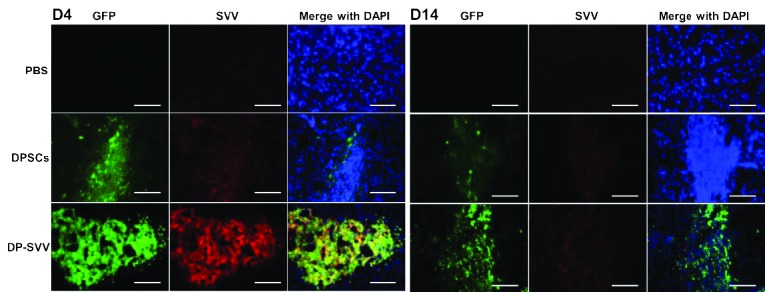
Survival of the control and DP-SVV cells in the wild-type C57B/6 mice 4 and 14 days after transplantation. Microscopic analysis of the immunofluorescence-labeled striatal sections in the cell-transplanted mice. Transplanted cells expressing GFP (green) were immunostained against SVV (red) and counterstained with DAPI (blue). Scale bar, 100 μm. DPSCs, dental pulp-derived stem cells; SVV, survivin; DP-SVV, SVV-modified DPSCs; PBS, phosphate-buffered saline; GFP, green fluorescent protein; DAPI, 4′,6-diamidino-2-phenylindole.